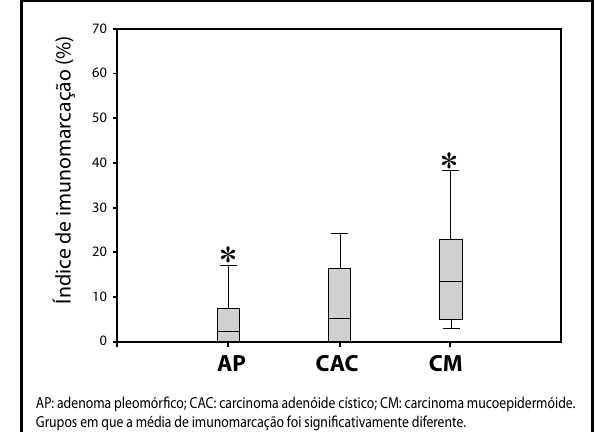
Figura 1 – Ausência de imunolocalização do antígeno p53 em carcinoma mucoepidermóide de baixo grau de malignidade demonstrada pela presença